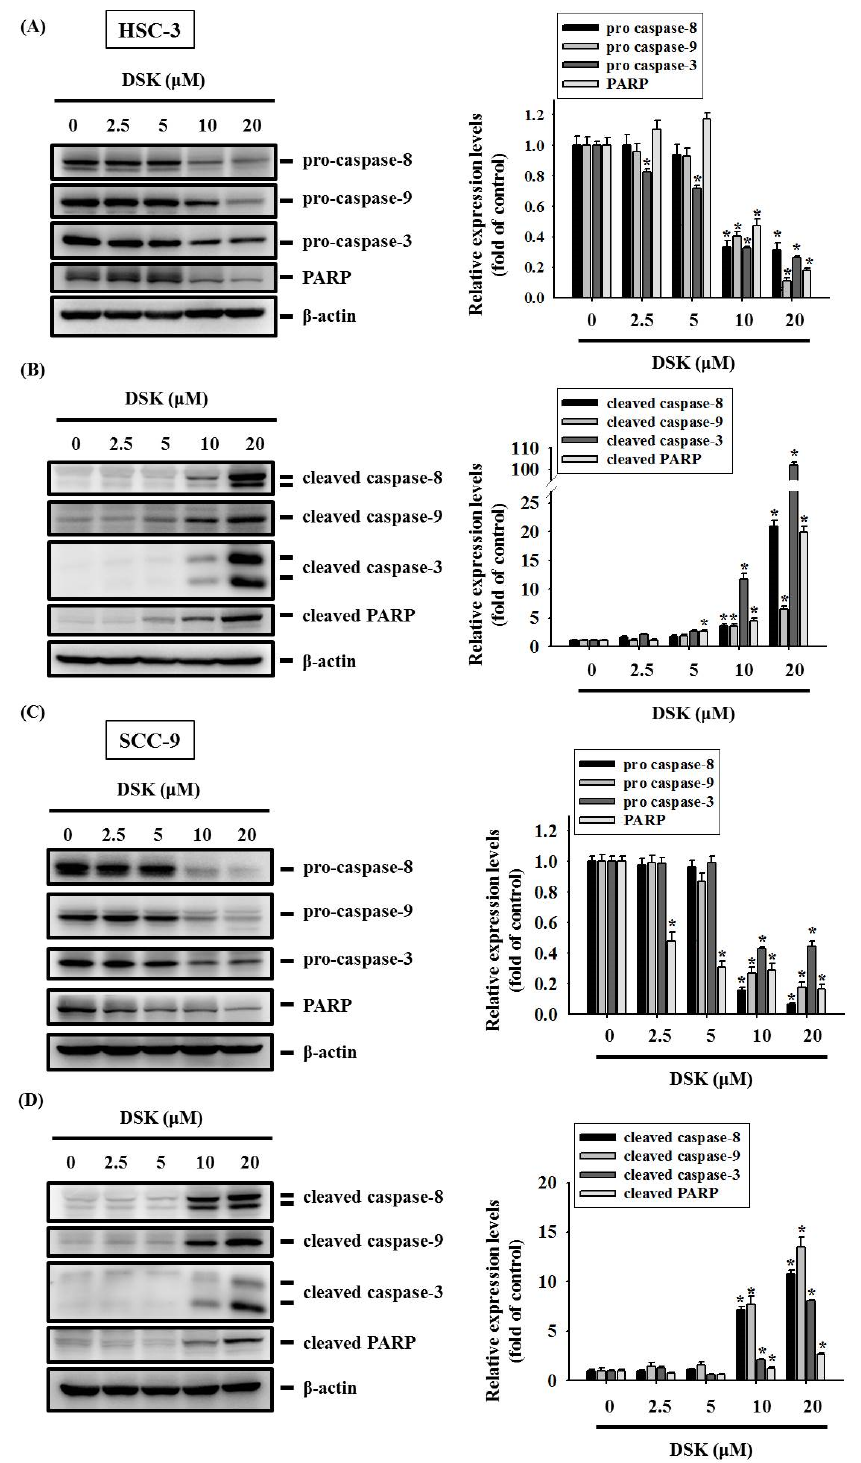
Figure 5. DSK stimulates the cleavage of pro-caspase-3, -8, and -9 in tongue cancer. HSC-3 and SCC-9 cells were treated with indicated concentrations of DSK for 24 h and assessed for the levels of intact ( A , C ) and cleaved forms ( B , D ) of caspases and PARP by immunoblotting with indicated antibodies. Densitometric analyses were quantified and normalized with internal controls ( β -actin). Data represent the mean ± SD of three independent experiments. * p < 0.05 compared with untreated controls using Student’s t -test.